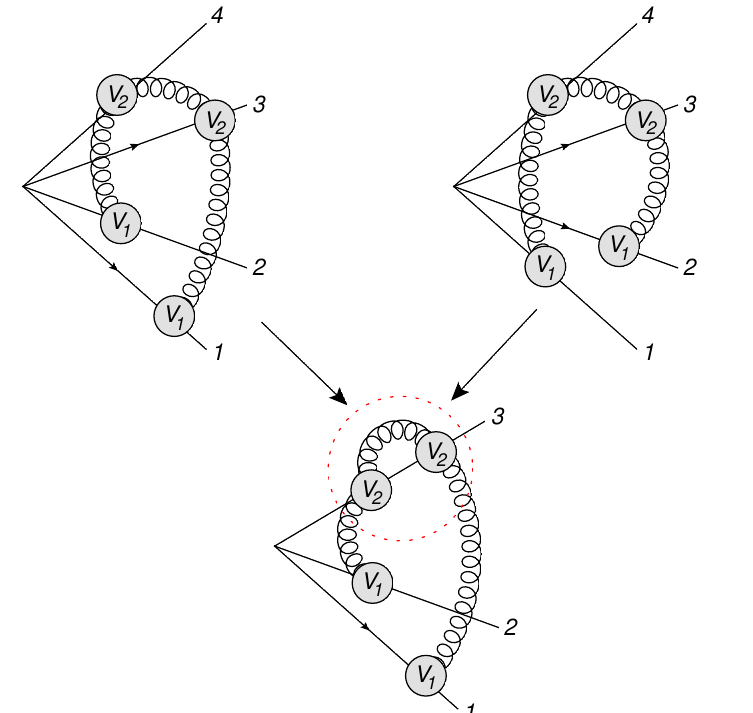
Figure 14 . Two different (1,1,2,2) webs w 1122 ( α 24 , α 34 , α 13 ) (top left) and w 1122 ( α 14 , α 34 , α 23 ) (top right), give a contribution to the (1,1,4) web in the limit that lines 3 and 4 are collinear. The red dashed circle indicates the symmetric contribution regarding the relative position of the two V vertices along line 3 is